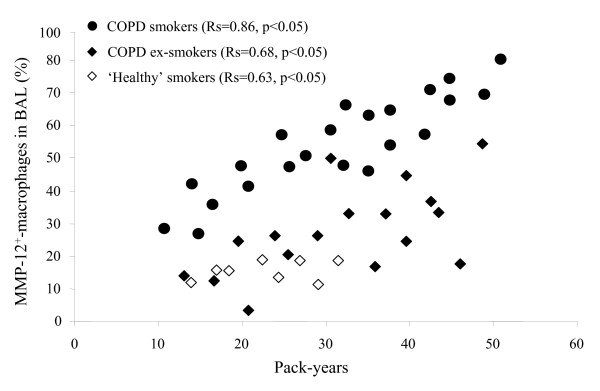
Smoking history and MMP-12+-macrophages. Correlation between smoking history (pack-years) and MMP-12+-macrophages (%) in BAL samples from COPD smokers, COPD ex-smokers and 'healthy' smokers (p < 0.05).